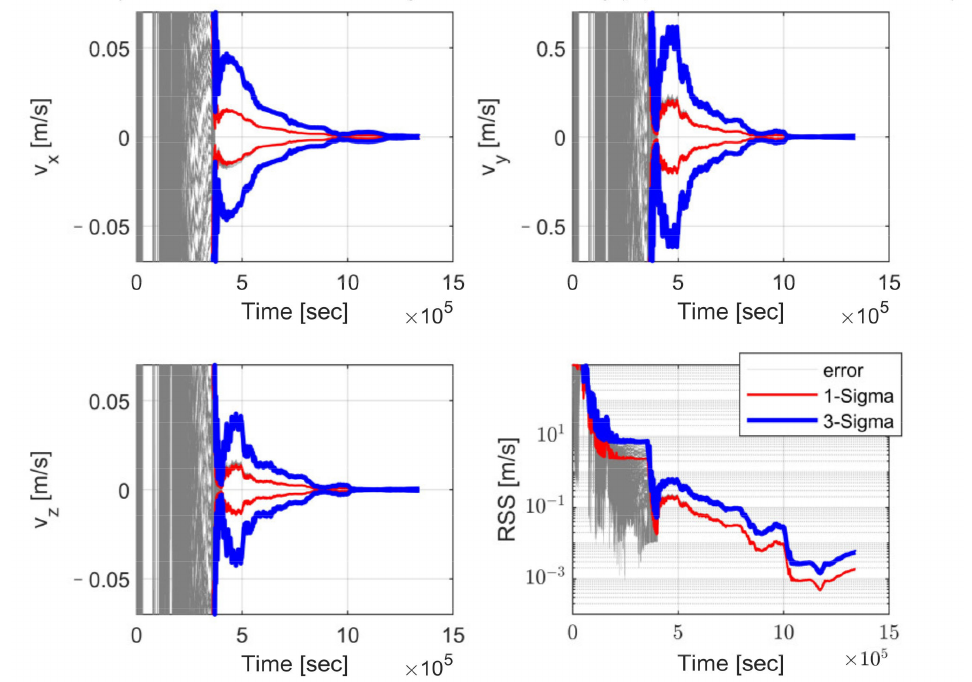
Figure 12. Angle-only navigation velocity errors along the resulting trajectory for 100 realizations and uncertainties (1-sigma uncertainty bound in red and 3-sigma uncertainty bound in blue) for the case with w = 0.3.